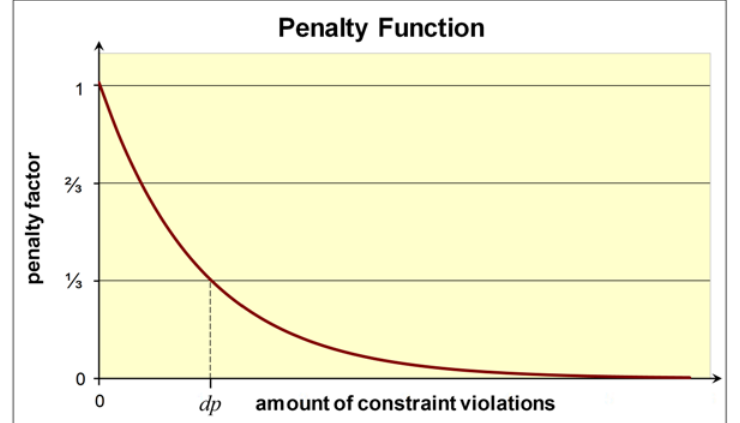
Figure 4. Example of a penalty function. It turns constraint violations into a penalty value between 1 and 0, which serves as a factor for decreasing the weighted